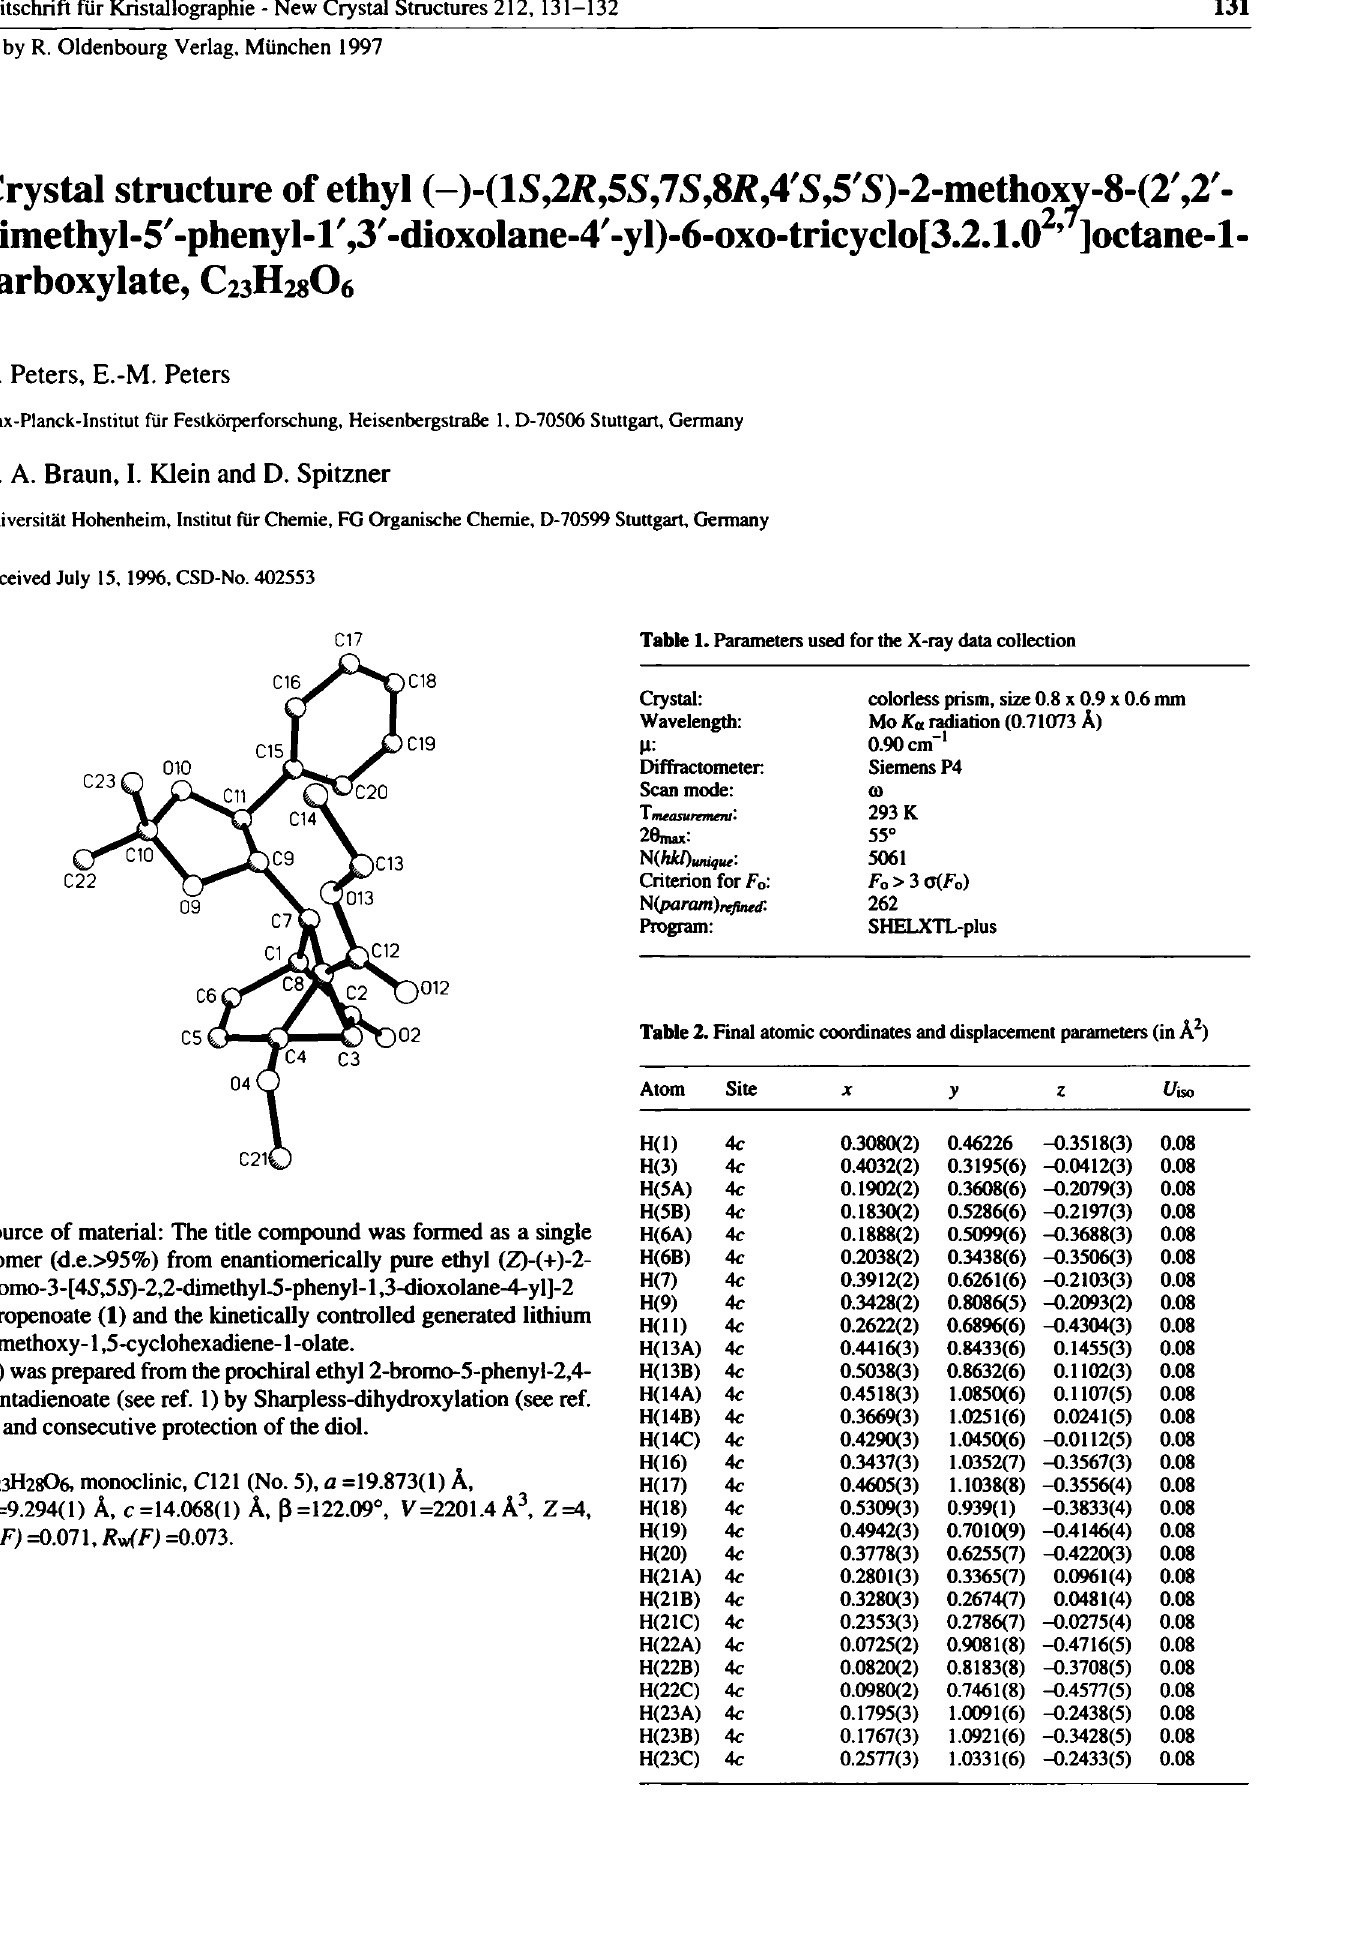
Table 2. Final atomic coordinates and displacement parameters (in Â 2